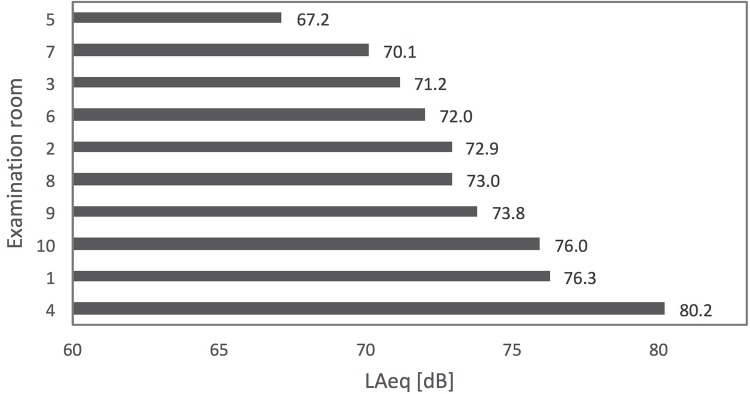
Equivalent sound levels (LAeq) in examination rooms.